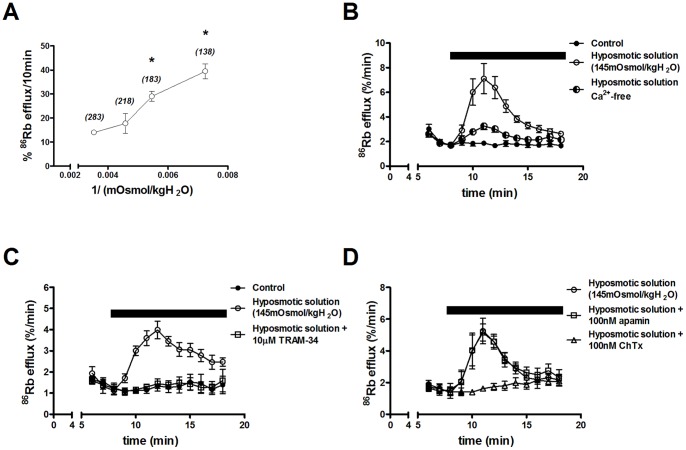
Hypo-osmolality activates IKCa.
A: Relationship between 86Rb efflux and extracellular fluid osmolality in multinucleated cytotrophoblasts at 66 h culture. The cells were bathed in Tyrode’s buffer with an osmolality of 283 (control), 218, 183 or 138 mOsm/kgH2O (shown in italics) for 10 min and the total 86Rb efflux over this period was plotted against 1/osmolality. Values are mean ± SE (n = 4–5 placentas); *p<0.001 vs. control at 66 h in culture; ANOVA with Turkey Kramer multicomparison post hoc test. B-D: Characterization of swelling-activated 86Rb efflux in multinucleated cytotrophoblasts (66 h). Time course of %86Rb efflux over 13 min; during the experimental period (indicated by the bar) cells were (B) untreated (control) or exposed to hyposmotic solution (145 mOsm/kgH2O) or Ca2+-free hyposmotic (n = 6 placentas); (C) control, hyposmotic solution or hyposmotic solution+TRAM-34 (n = 5 placentas); (D) hyposmotic solution, hyposmotic solution+apamin or hyposmotic solution+charybdotoxin (ChTx) (n = 5 placentas). Data are mean ± SE.